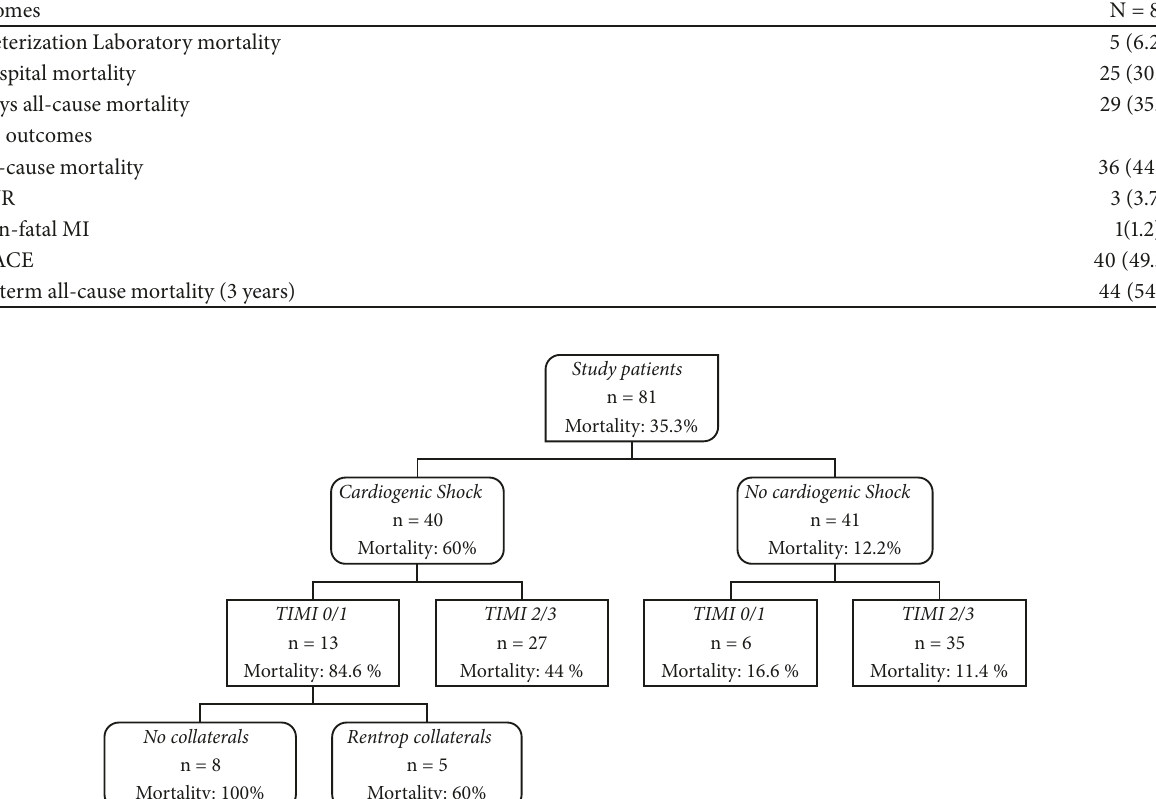
Table 3: Outcomes at 30-day, 1-year, and 3-year follow-up. Values are number (%). MACE = major adverse cardiac events, MI = myocardial infarction, and TVR = target vessel revascularization.